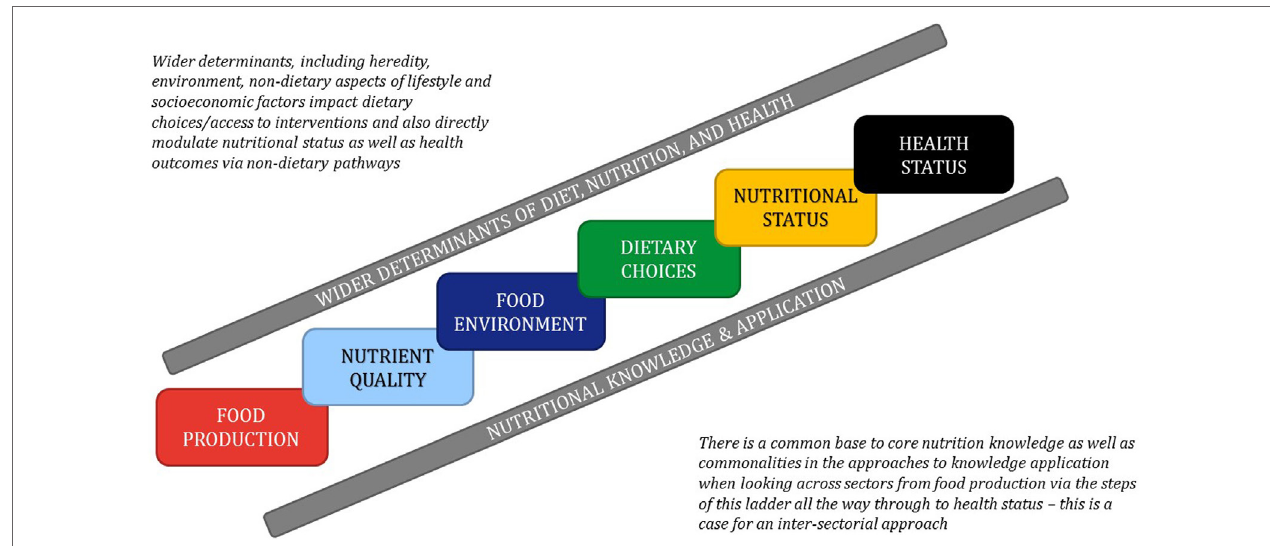
FigUre 1 | A schematic representation of the conference